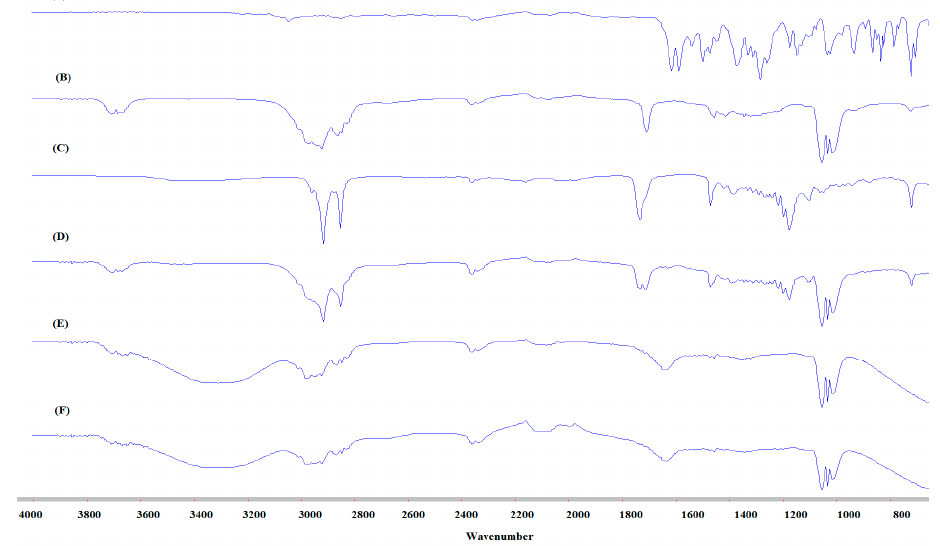
Figure 3. Fourier Transform Infrared Spectroscopy (FTIR) spectra of ( A ) Ciprofloxacin (CIP), ( B ) Oleic acid, ( C ) Precirol ® ATO 5, ( D ) physical mixture (CIP, oleic acid and Precirol ® ATO 5), ( E ) blank NLC, and ( F ) CIP-NLC formulation.